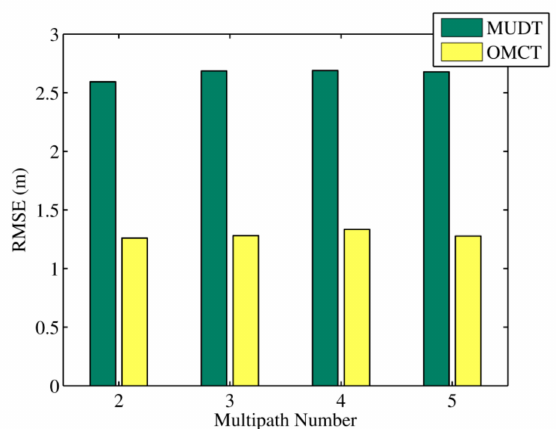
Figure 5. The RMSEs of MUDT and OMCT under di ff erent multipath numbers in the